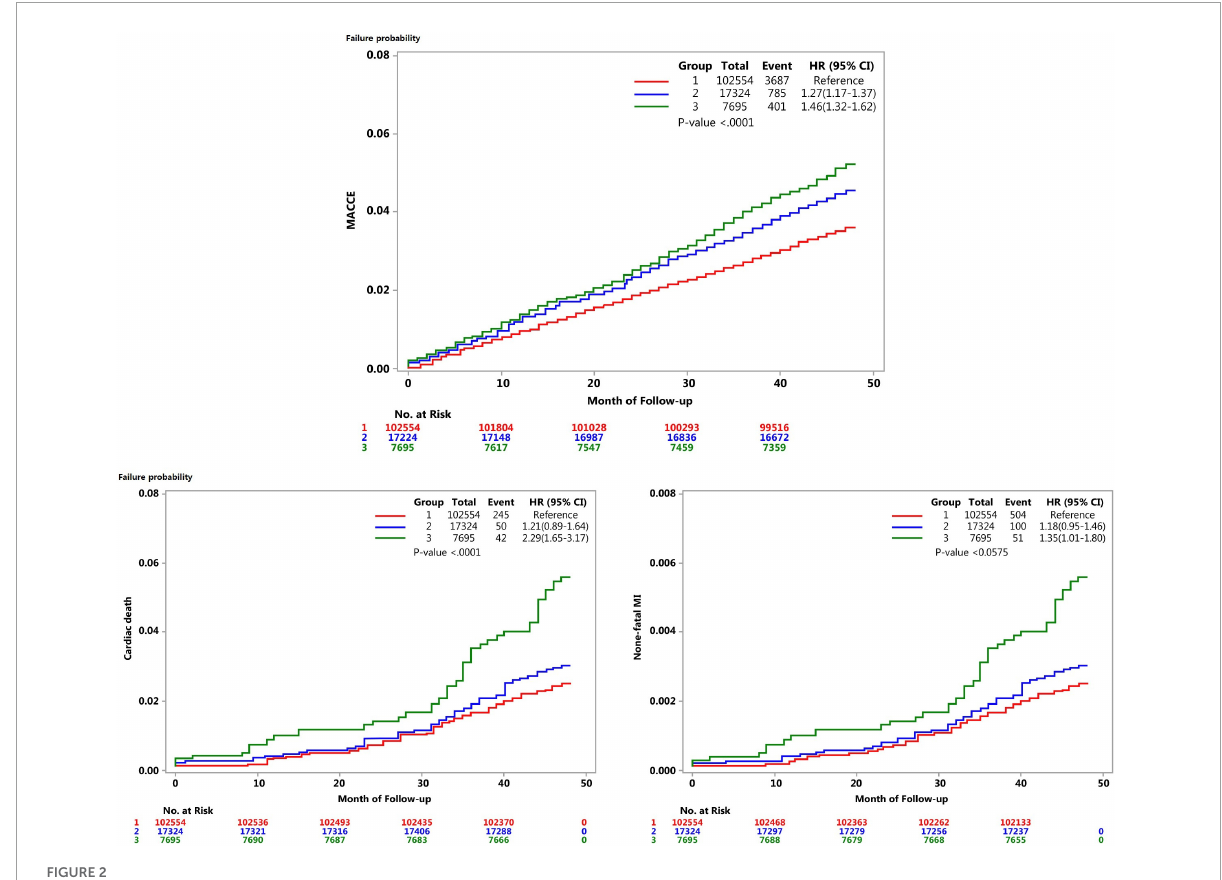
FIGURE2 Kaplan–Meier curves for major adverse cardiovascular and cerebral events.